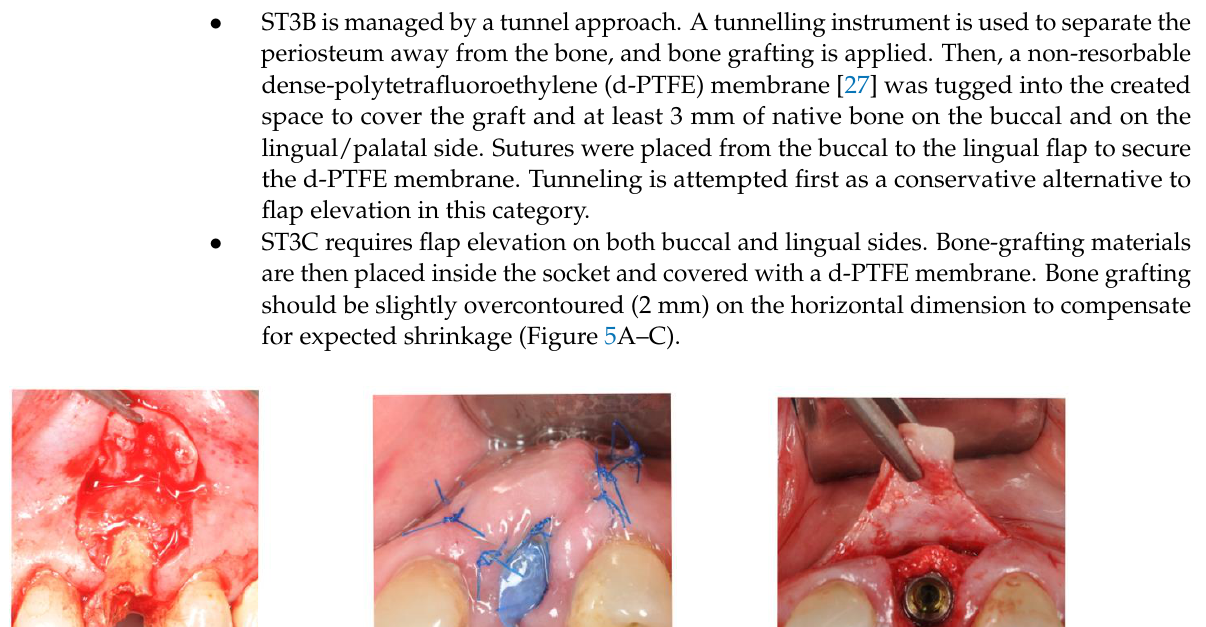
Figure 4. ( A ): After extraction of the upper left central incisor, socket anatomy displayed dehiscence of the facial bone. The socket was classified as Socket type 3A (ST3A). ( B ): A collagen cross-linked membrane was trimmed to have a V-shape and then placed over the dehiscence while still protruding out of the socket. Bone-grafting particulate was placed to fill the socket. The membrane was reflected to cover bone grafting, and sutures were placed to stabilize the membrane. ( C ): Surgical re-entry at the time of implant placement revealed successful ridge preservation and allowed desired implant positioning.